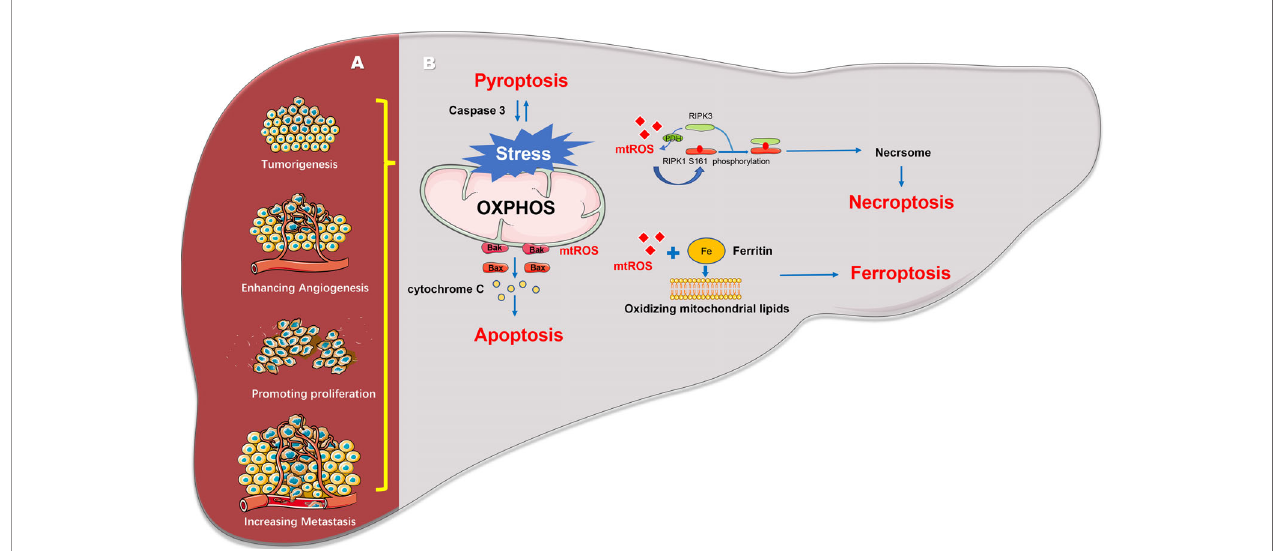
FIGURE 1 | Mitochondrial regulates the progression and death of hepatocellular carcinoma. (A) Mitochondria can reverse regulate the expression of nuclear genes to induce cell tumorigenesis, angiogenesis, cell proliferation, invasion, and metastasis. (B) Mitochondria can regulate various cell death pathways including apoptosis, necroptosis, pyroptosis and ferroptosis and so